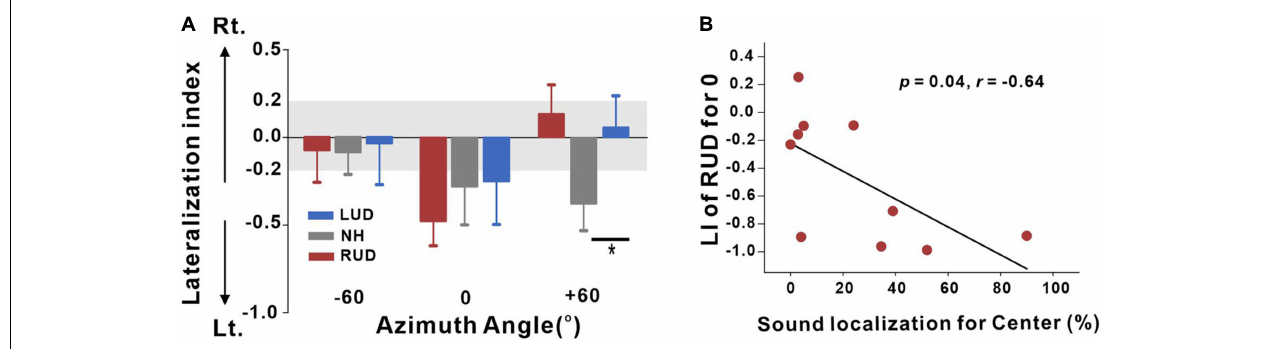
FIGURE 6 | (A) Lateralization index (LI) plots at –60 ◦ , 0 ◦ (center), and +60 ◦ azimuth angles for the RUD, LUD, and NH groups. The gray regions in the LI plots indicate a 0.2 criterion for laterality. (B) Significant negative correlations for the RUD group between percent correct values on sound localization task and LIs for the center. Error bars: standard error of the mean. * P < 0.05. RUD, right-sided unilaterally deaf; LUD, left-sided unilaterally deaf; NH, normal